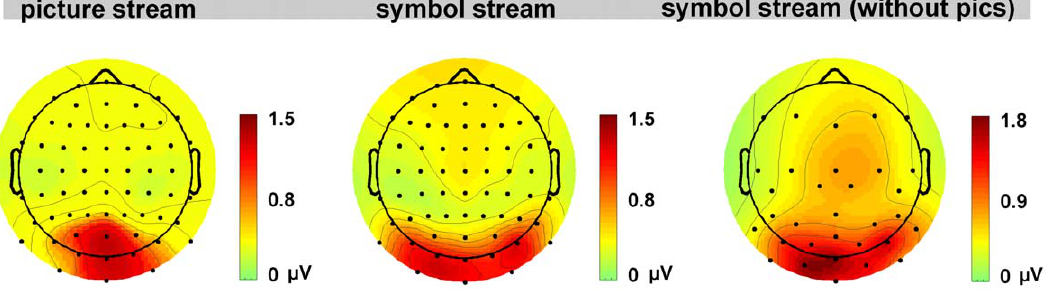
Figure 4. Iso-contour voltage maps. Iso-contour voltage maps of SSVEP amplitudes at the corresponding stimulation frequency averaged across experimental conditions for the main- and the control experiment where the identical symbol stream was presented yet without IAPS pictures in the background.